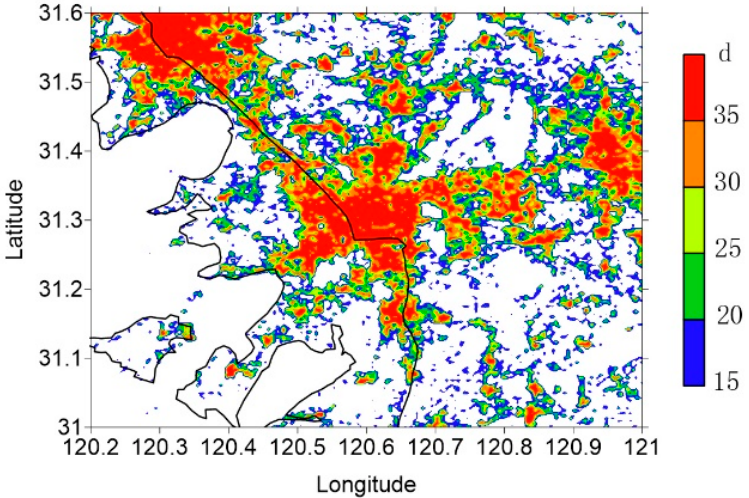
Figure 10. Same as Figure 2 but for annual average extreme caution day numbers.